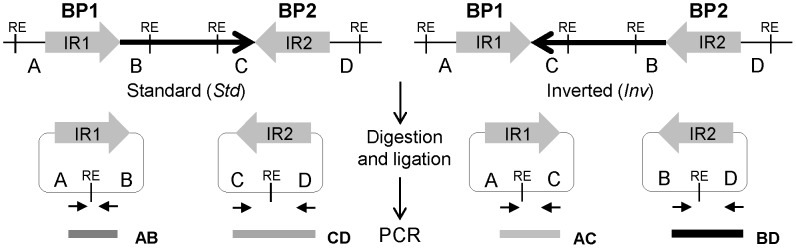
Diagram of iPCR validation of inversions mediated by inverted repeats (IRs).Standard and inverted arrangements are represented by unique regions A, B, C and D, which are separated by IR1 and IR2 at each inversion breakpoint (BP). The iPCR involves three steps: digestion at the restriction enzyme target sites (RE), circularization of the digested fragments by self-ligation, and PCR amplification with primers (small arrows) flanking the restriction site to generate products of different size depending on the orientation of the segment between both repeats.